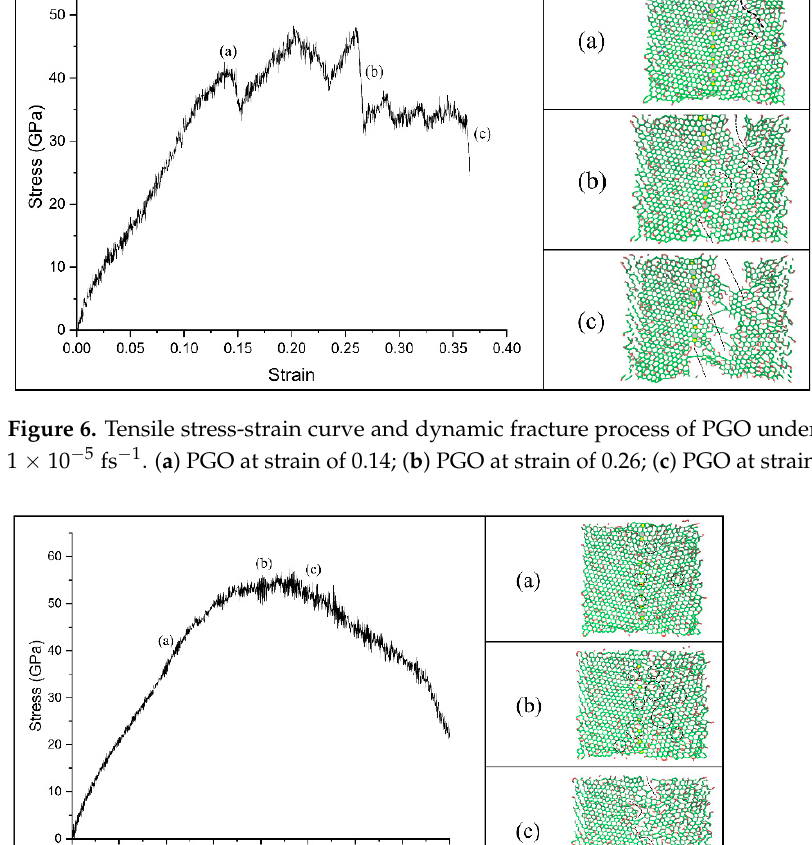
Figure 7. Tensile stress-strain curve and dynamic fracture process of PGO under the strain rate of 2.5 × 10 − 4 fs − 1 . ( a ) PGO at strain of 0.1; ( b ) PGO at strain of 0.2; ( c ) PGO at strain of 0.24.